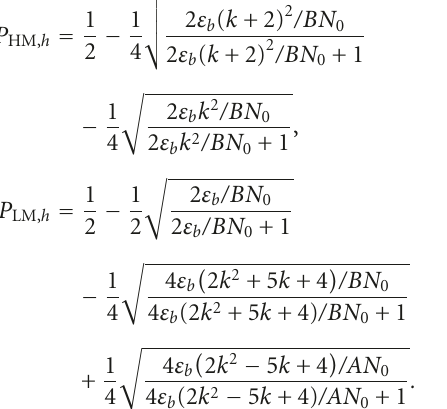
Figure 8: SNR Gap versus k curve over flat Rayleigh fading channel. The target ber for high priority bits is 1 e − 7 and the target ber for low priority bits is 1 e − 4.